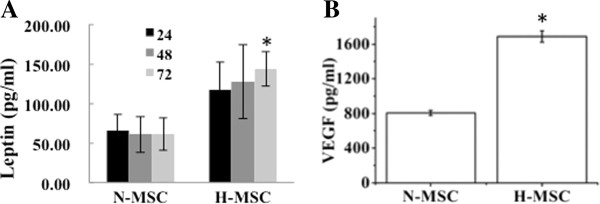
Quantification of leptin and VEGF protein in MSC spent media during exposure to hypoxia. (A) Numbers in left panel refer to time (h) under hypoxia. (B) VEGF incubation time was 24 h. All results are representative of 3 separate experiments; *p < 0.05, n = 3.